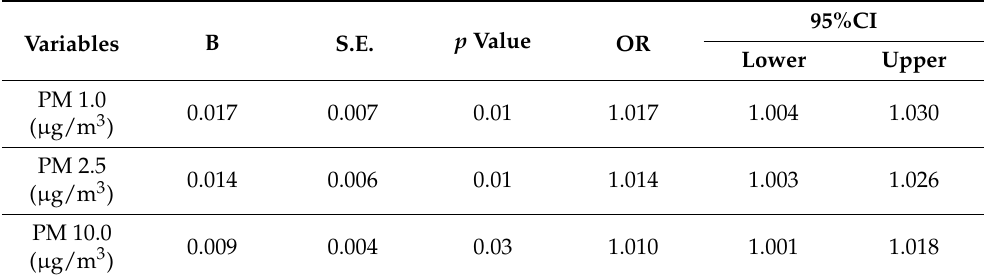
Table 3. Univariate binary logistic regression analysis between average PM values (continuous scale) and frequent exacerbations.